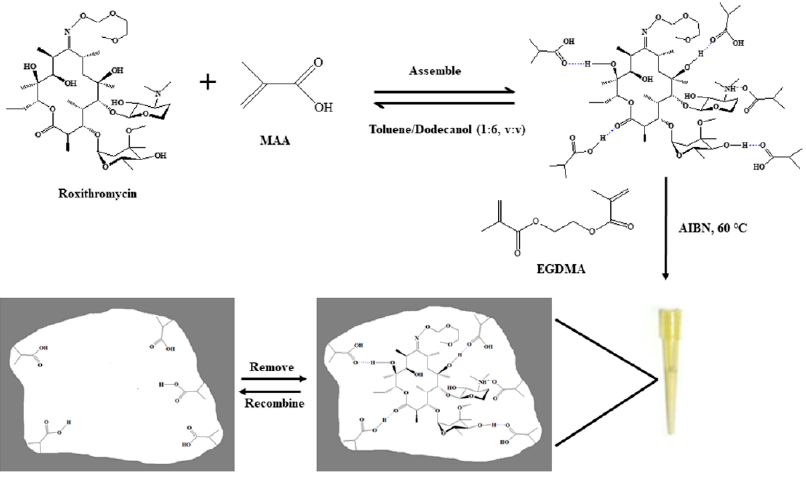
Figure 1. Schematic diagram of the preparation of molecularly imprinted monolithic column.